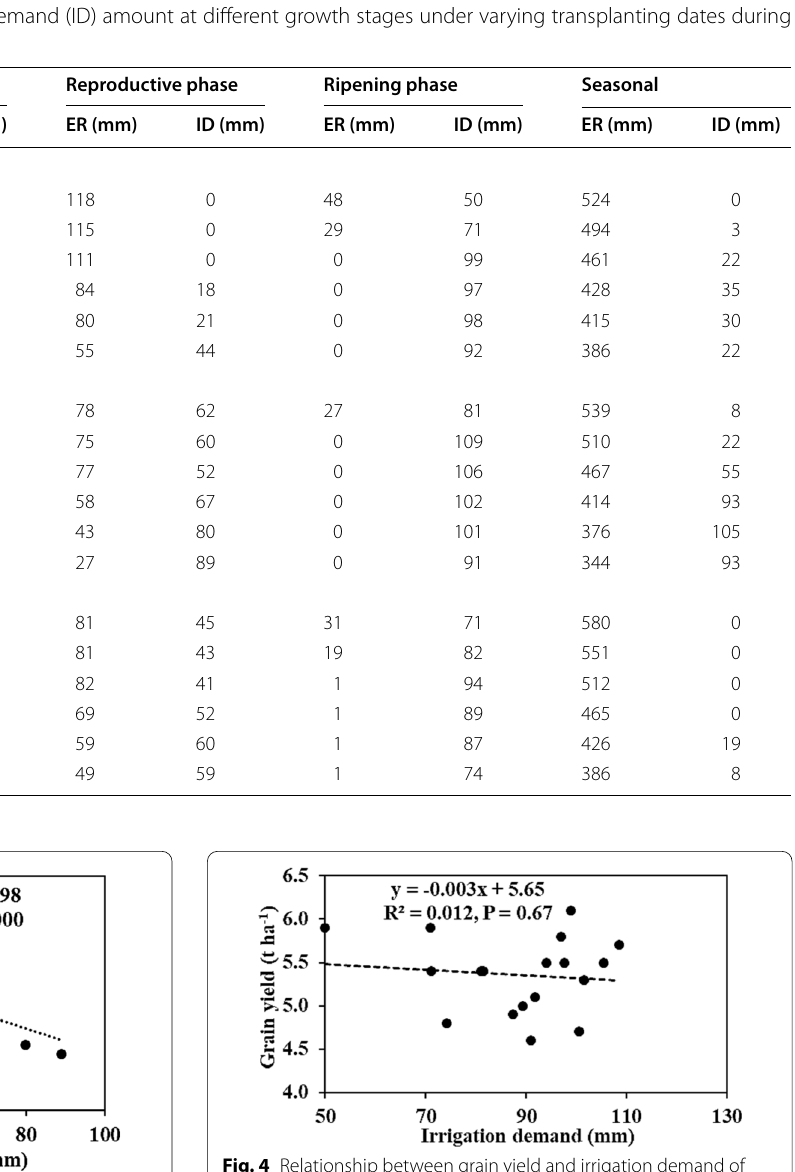
Fig. 3 Relationship between grain yield and irrigation demand of BR11 at reproductive phase in Kushtia during T. Aman, 2013–2015